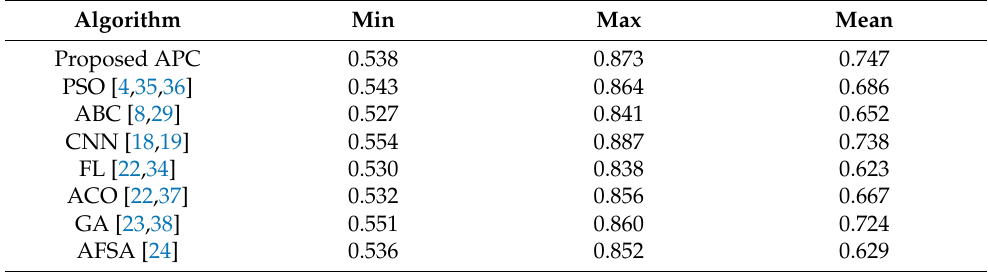
Table 3. Node positioning data statistics on positioning accuracy (200 sensor nodes, communication range r = 20 m, 20% anchor nodes, population size m =